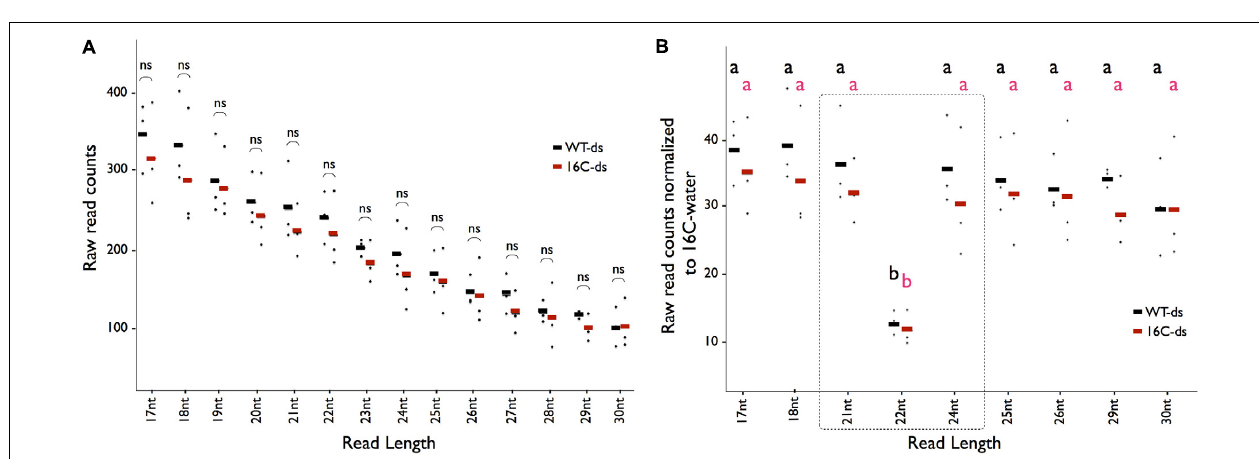
FIGURE 2 | Distribution of sRNAs matching the GFP sequence. (A) The average abundance of sRNA-seq reads mapping to the GFP sequence for the given read length ( X -axis) in WT-ds (black), 16C-ds (red) lines. Each dot represents one biological replicate in the given condition. Student t -test shows that there is no significant (ns) enrichment of an sRNA in 16C-ds samples when compared to WT-ds samples. (B) The number of reads with specific length mapping to the GFP in 16C-ds (red) and WT-ds (black) samples normalized to 16C-water samples does not show any enrichment of a specific class of sRNA. One-Way ANOVA test shows that there is only depletion of 22nt-long siRNA but no enrichment of sRNAs associated with gene silencing (shown in the dotted square). All data are based on the evaluation of three biological replicates and each dot represents one data point. Significant differences (a and b) were calculated by one-way ANOVA, Bonferroni’s post test P < 0 .